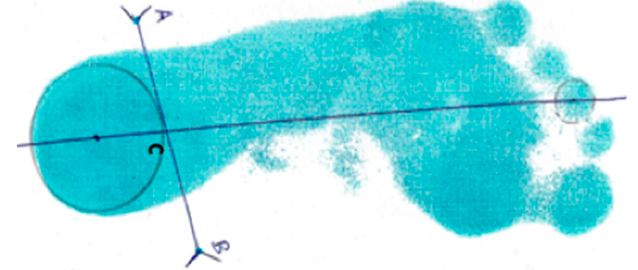
Figure 2. Measure of the Valgus Index with the following formula (1/2AB − AC) ×